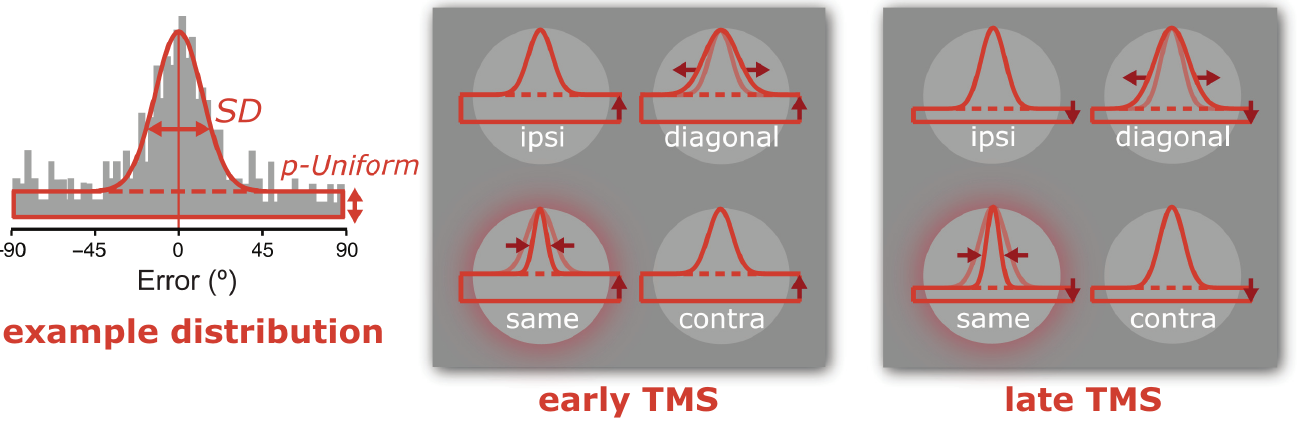
Fig 5. Cartoon summaryof results. The left most panel depicts an examplerecall distribution.The frequencyof recall errors (i.e. difference between responseand target orientation) is indicatedby the height of the grey bars. A mixture model fit of the recall errors is depictedin thick orangelines. Most responses are centeredaround0˚, and the precisionof memory recall is capturedby the mixture model SD parameter (smaller SD indicatesmore precision). Some proportionof responsesappearto be random, indicatedby the probabilityof guess-likeresponses (smaller p-Uniform indicatesless guessing). The two rightmost panelsprovide a cartoon summary of our main results (exaggerated and simplifiedfor illustrative purposes). First, the main effect of relativelocation is highlightedby increasedmemory precision( SD ) at the locationtargeted by TMS (‘same’) comparedto the control quadrant (‘diagonal’) for both early and late TMS pulses (compare SD at four visual field locations). Second, the main effect of pulse timing is shown by increased guessingwhen pulses were appliedearly comparedto pulses appliedlate irrespective of visual field location(compare p-Uniform betweenmiddleand right most